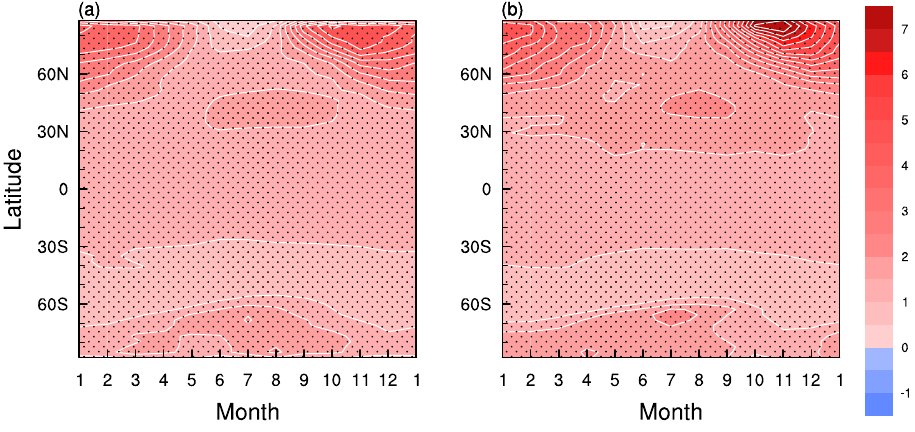
Fig. 10. Latitude-month plots of zonal-mean SAT trends for AR4 models. (a) AR4-NO-O 3 models and (b) AR4-O 3 models. Colour interval is 0.50K per 50 years, pink: positive, and blue: